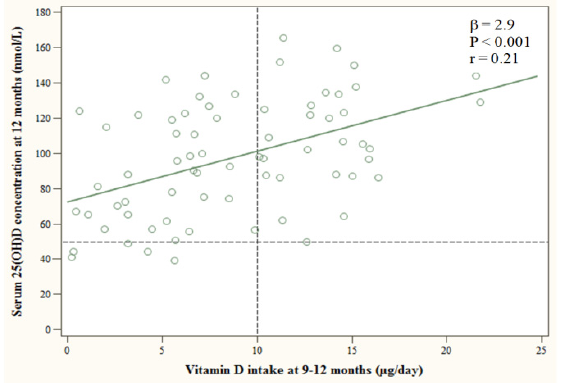
Figure 2. The linear regression line for serum 25-hydroxyvitamin D (25(OH)D) at 12 months in relation to vitamin D intake from diet and supplements at 9–12 months. The dashed horizontal line at 50 nmol/L is the cut-off line applied for a sufficient vitamin D status, and the dashed vertical line at 10 μ g indicates the Nordic recommended intake (RI).